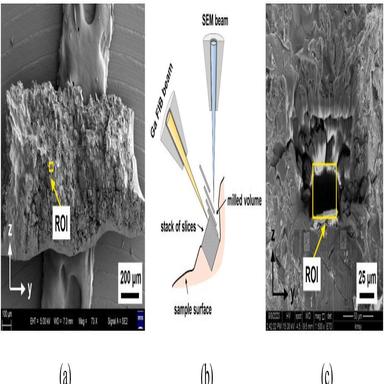
Loess sample and setup of the FIB-SEM test. (a) SEM image of the loess sample for μXCT and FIB-SEM tests, with the location of the region of interest (ROI) for FIB-SEM analysis marked. (b) Schematic illustration of the FIB-SEM setup. (c) SEM image of the loess sample surface after the FIB-SEM test, showing the trench caused by milling the material.